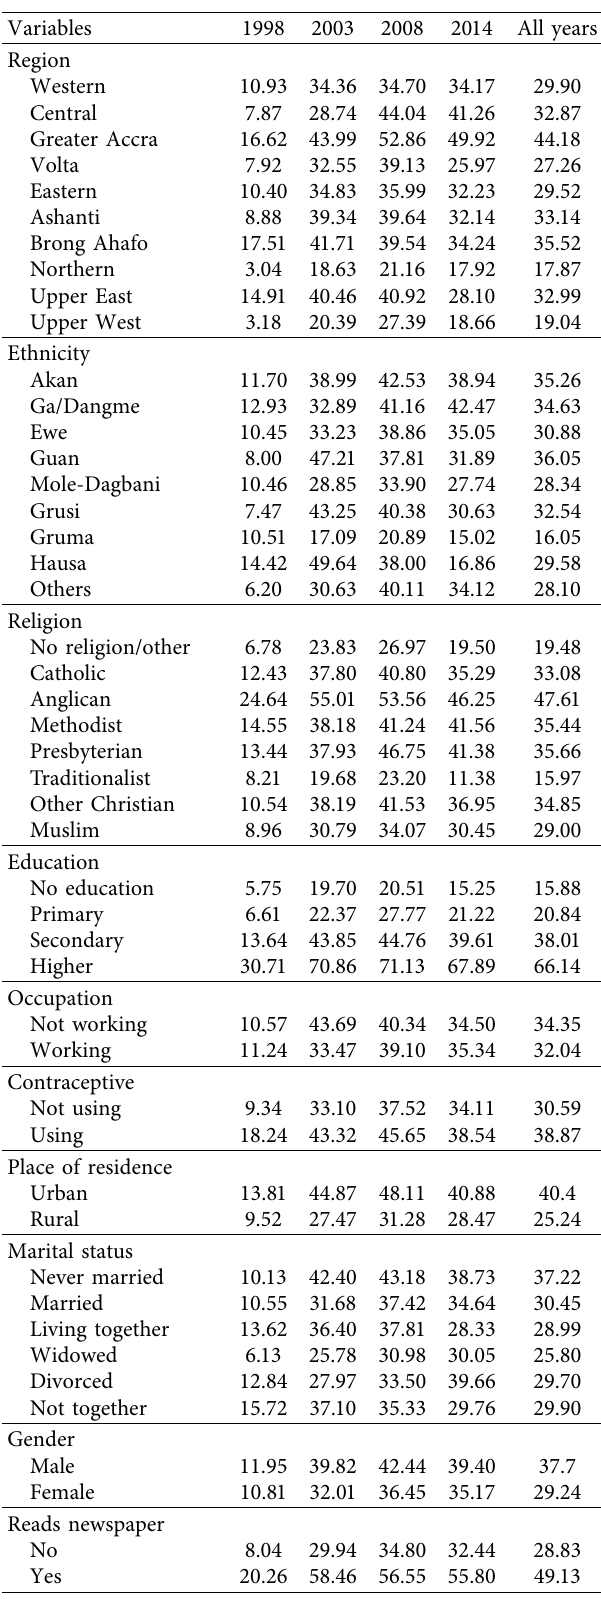
Table 1: Percentage distribution of categories within variables with comprehensive knowledge (CK) of HIV and